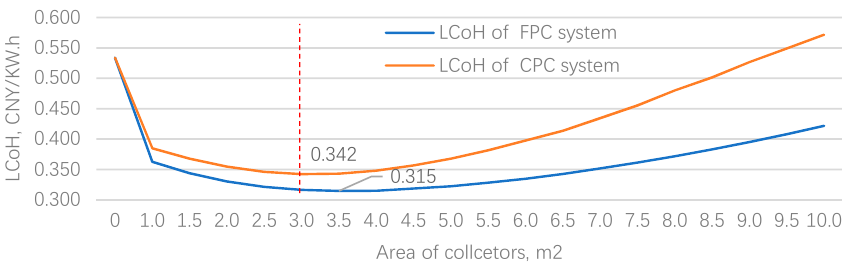
Figure 14. The solar fraction trend with the area (m 2 ) of CPC and FPC.